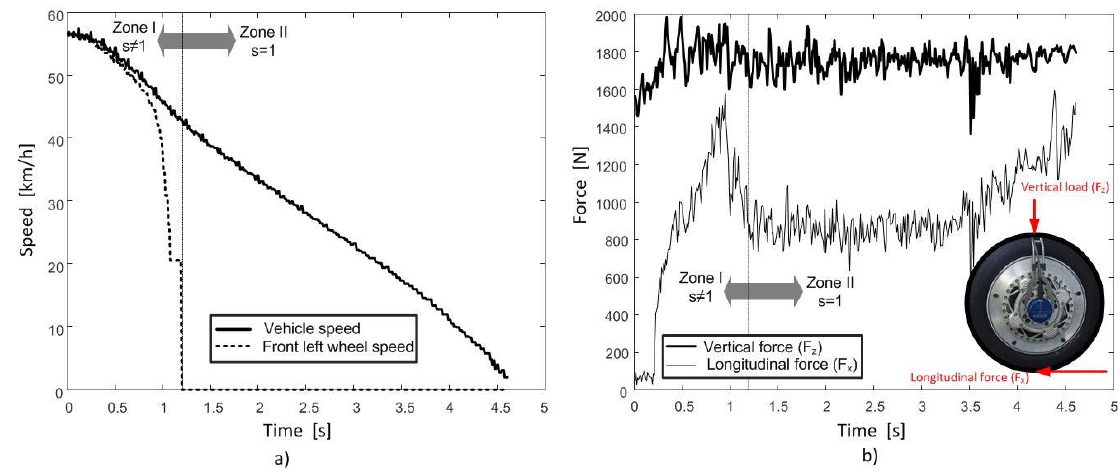
Figure 3 . Example of data measured in a regular test. ( a ) Vehicle and wheel peripheral speed. ( b ) Tyre forces.